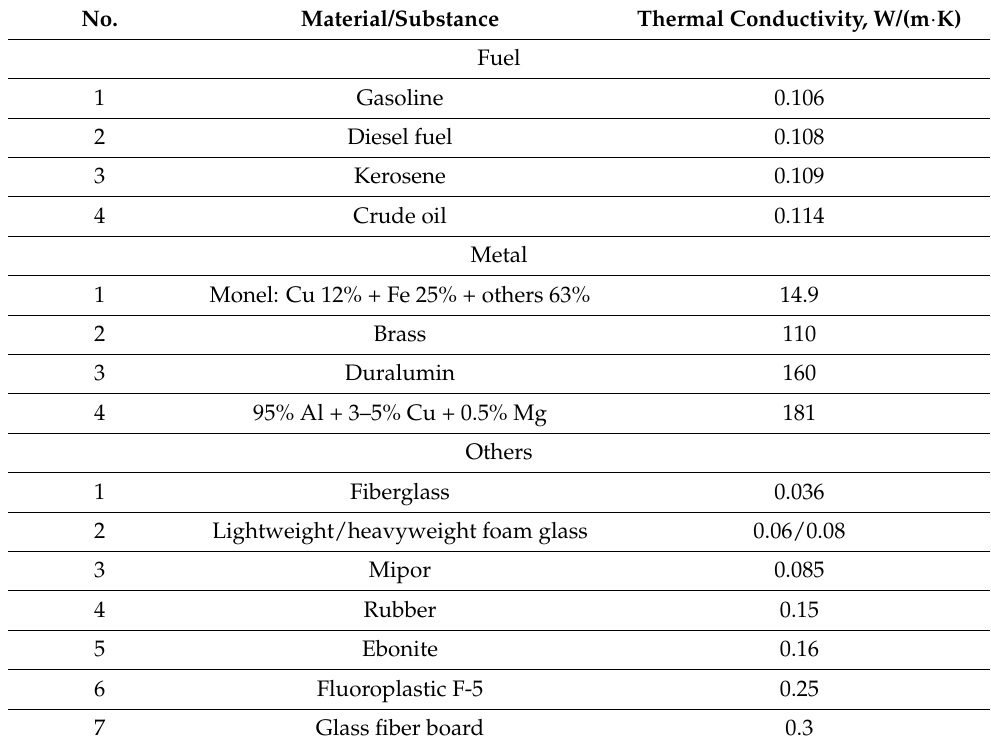
Table 1. Thermal conductivity of petroleum fuels and different flowmeter tube materials, t = 20 ◦ C